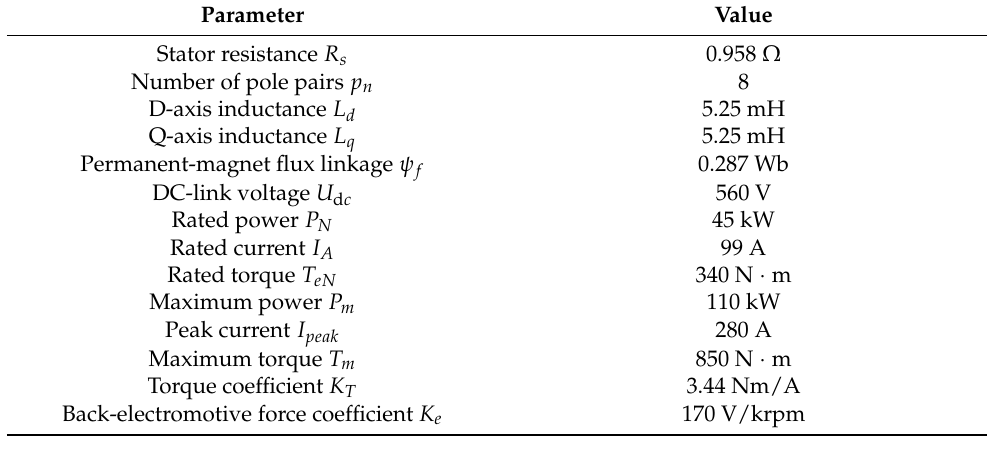
Figure 5. Torque speed diagram of the motor.